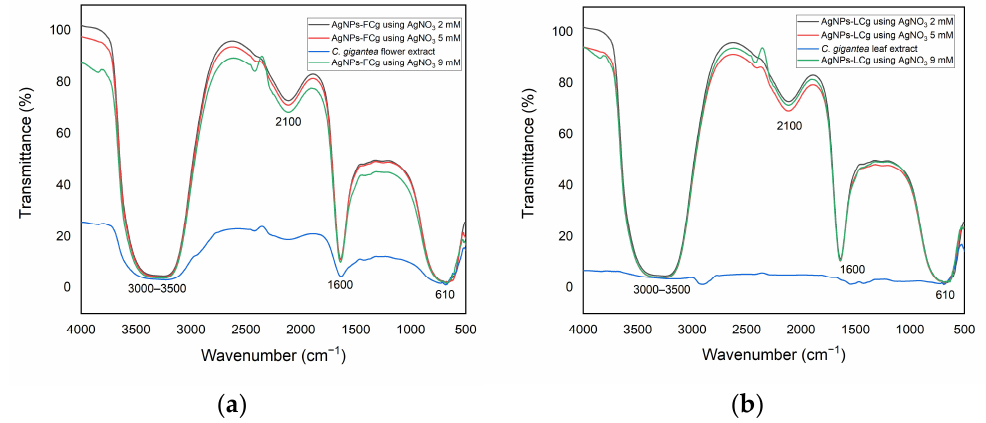
Figure 3. FTIR spectra of ( a ) AgNPs-FCg and ( b ) AgNPs-LCg at several concentrations of AgNO 3 .